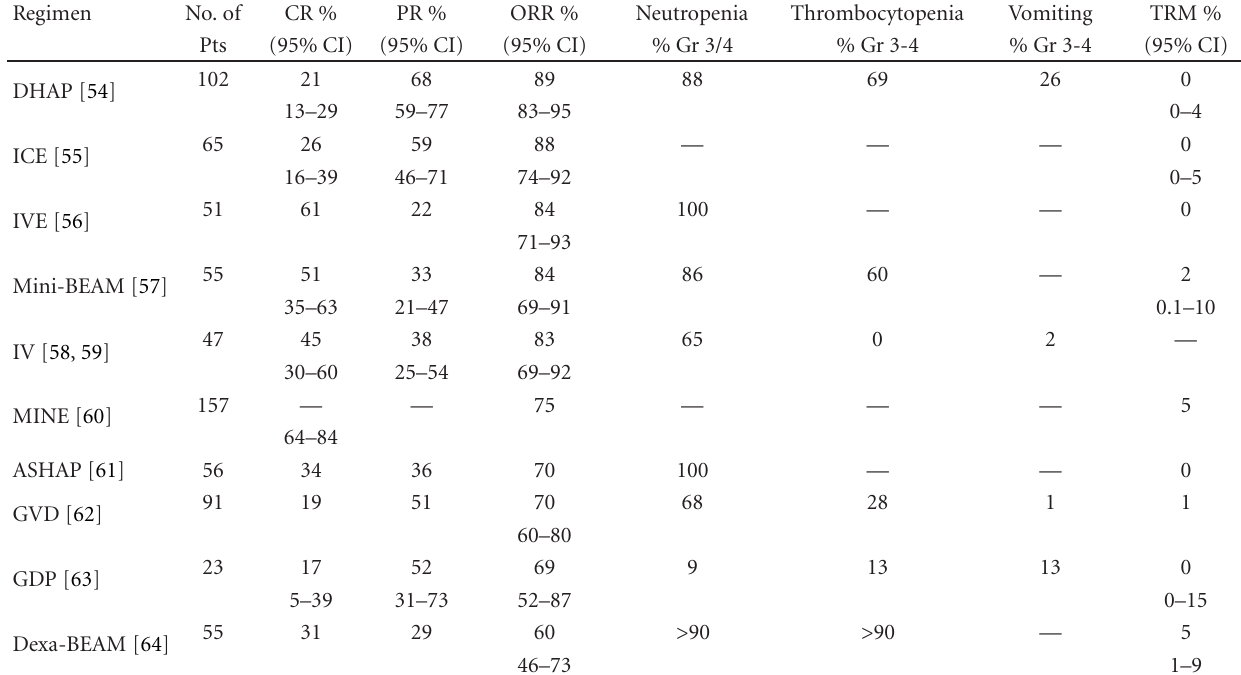
Table 7: Summary of outcomes of nonrandomised trials of salvage treatments in relapsed and refractory Hodgkin’s lymphoma, arranged in descending order of ORR. Abbreviations: CR: complete remission; PR: partial remission; ORR: overall response rate; TRM: treatment- related mortality; DHAP: dexamethasone, cytarabine, and cisplatin; ICE: ifosfamide, carboplatin, and etoposide; IVE: ifosfamide, etoposide, and epirubicin; IV: ifosfamide, vinorelbine; Mini-BEAM: BCNU, etoposide, cytarabine, and melphalan; Dexa-BEAM: dexamethasone,